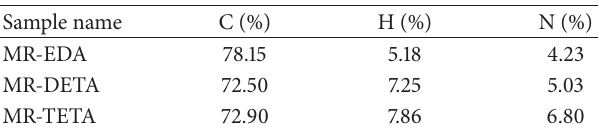
Figure 4: ATR - FTIR of MR-EDA-TCEP resin (e), MR-DETA-TCEP resin (f), and MR-TETA-TCEP resin (g). Table 1: Elemental analysis results of MR-EDA, MR-DETA, and MR-TETA